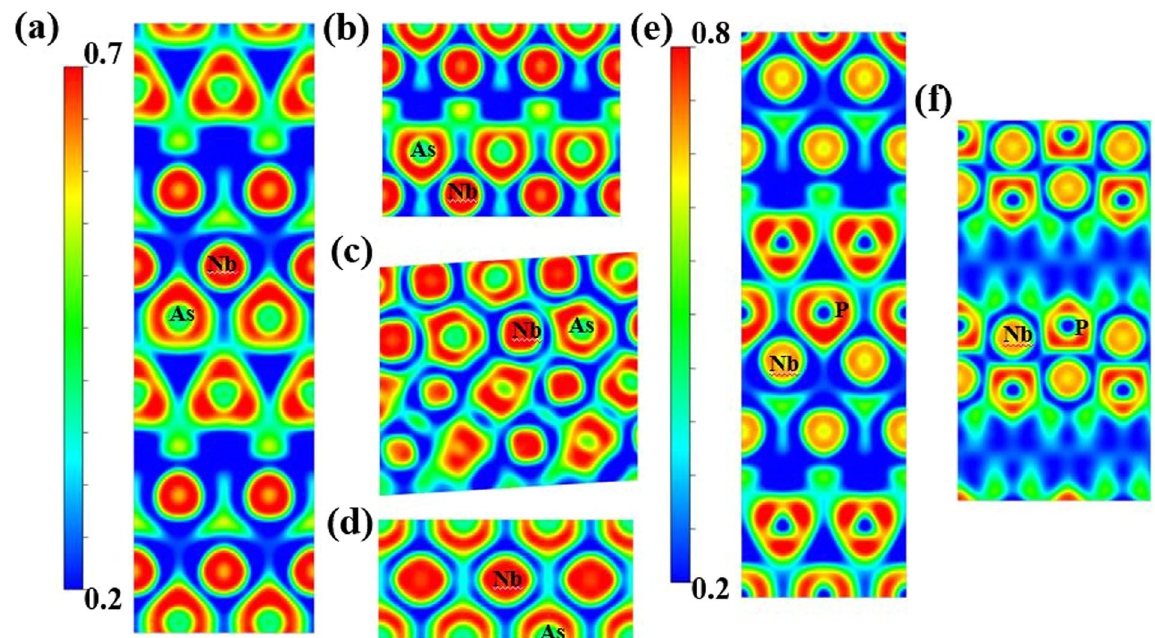
Figure 5. Calculated electron localization functions of NbAs and NbP at different pressures. (a) I4 1 md structure of NbAs on the (100) surface at 0 GPa, (b) P -6m2 structure of NbAs on the ¯ (210) surface at 30 GPa, (c) P2 1 /c structure of NbAs on the ¯ (3041) surface at 50 GPa, (d) P m-3m structure of NbAs on the (110) surface at 80 GPa, (e) I4 1 md structure of NbP on the (100) surface at 0 GPa, and (f) C mcm structure of NbP on the ¯ (101) surface at 80